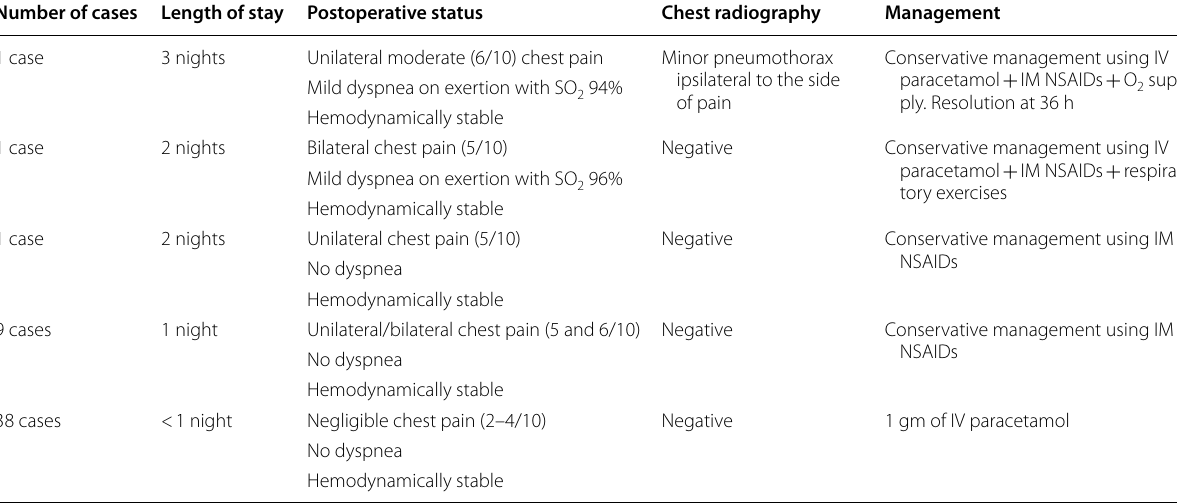
Table 2 Length of hospital stay and postoperative conditions Number of cases Length of stay Postoperative